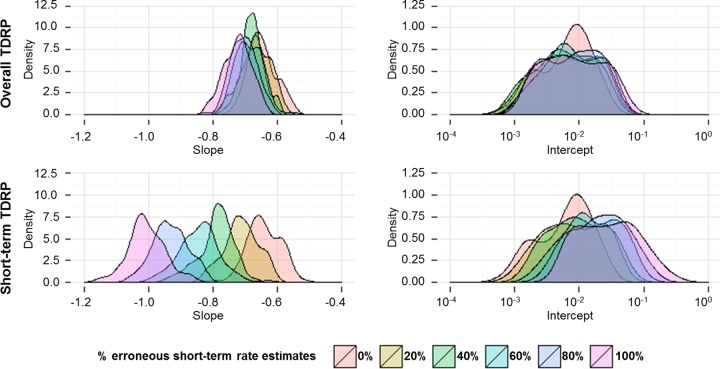
Effects of erroneous short-term rate estimates derived from noncorrelated substitution numbers and timescales of rate measurement on the rate decay curve inference. Simulations were used to examine how the presence of erroneous short-term rate estimates may bias the time-dependent rate phenomenon (TDRP) analyses, assuming a nonhomogeneous Poisson evolutionary process and a power law rate decay curve. Left and right graphs show slope and intercept estimates, respectively, of the rate decay curve, computed in the presence of 20%, 40%, 60%, 80%, and 100% erroneous short-term rate estimates. Top and bottom graphs show how the erroneous short-term rates affect overall and short-term TDRP curves, respectively. The intercept and slope of the rate decay curve obtained from control simulations (0% erroneous rate estimates) were used as controls.